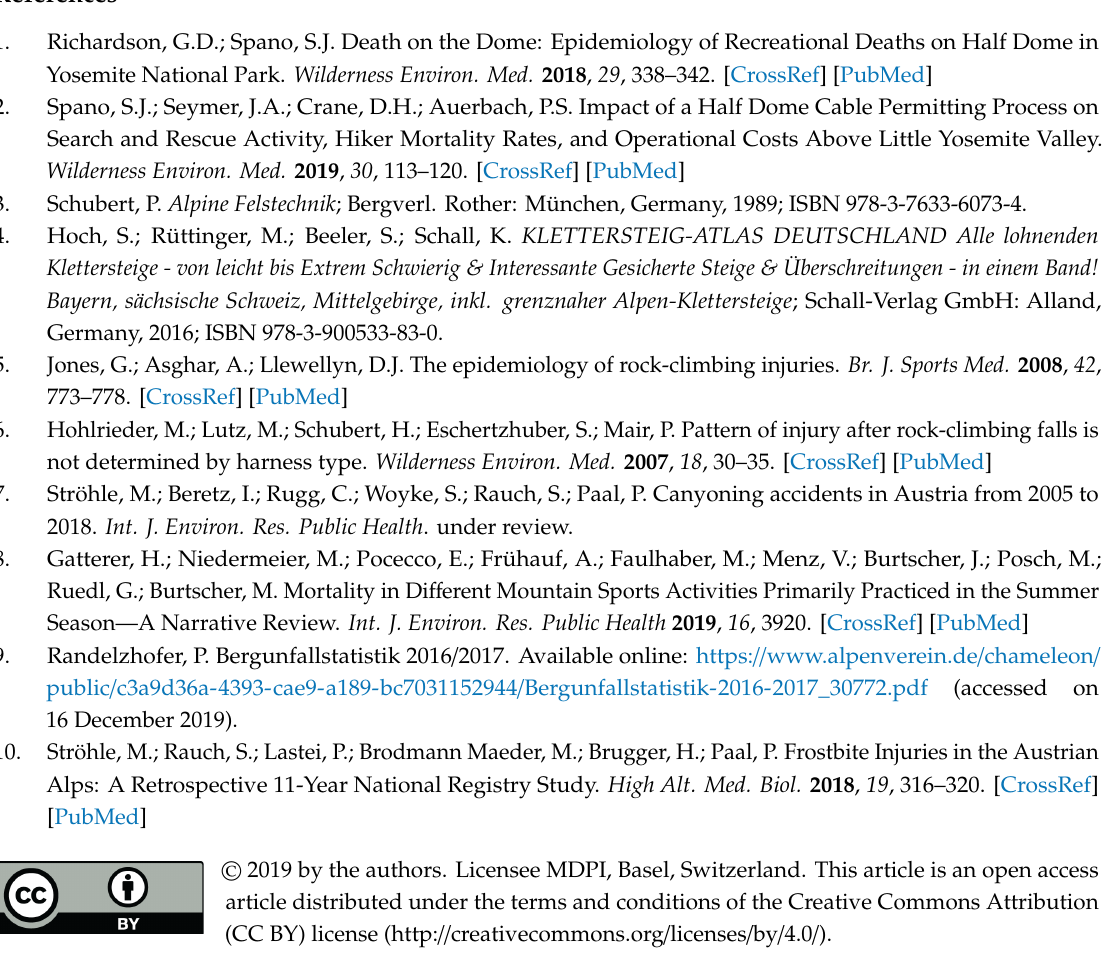
Figure S1: CONSORT flowchart of data acquisition in via ferrata accident, Figure S2: Case Report Form, Figure S3: Persons involved in via ferrata emergencies in Austria per year, itemized by cause of accident, Table S1: Via ferrata grading using the Austrian Scale, Table S2: Activity vs. injury classification in via ferrata emergencies, Table S3: Classification of via ferrata di ffi culty in relation to rescue e ff orts for via ferrata